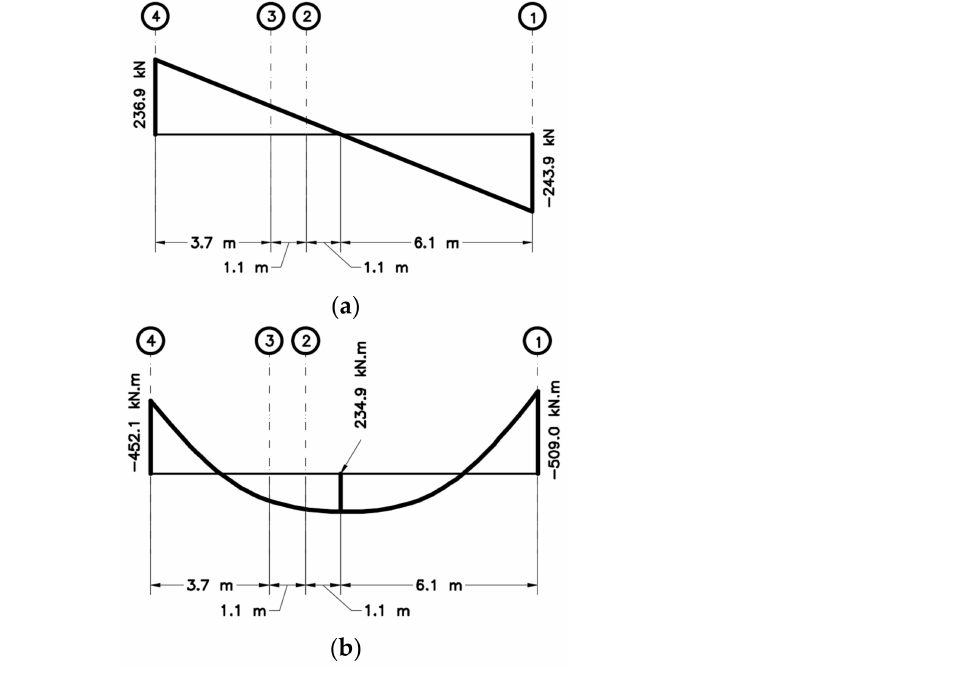
Figure 12. Efforts in beam V3 to the initial time instant t = 0: ( a ) shear force (kN); ( b ) bending moment (kN m).